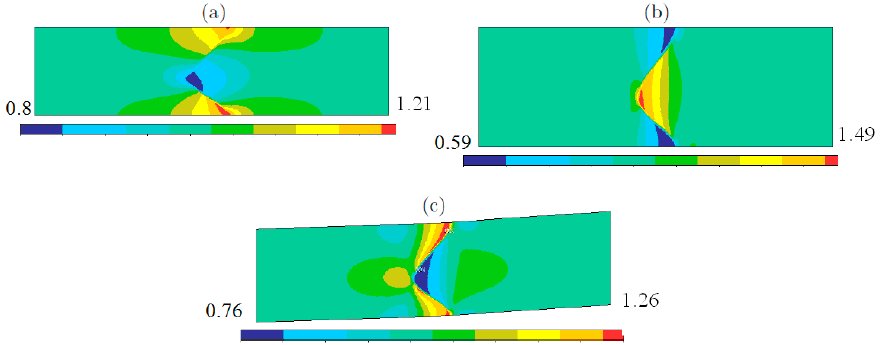
Figure 5. The local von Mises stresses corresponding to the shift for ( a ) symmetric wave, ( b ) asymmetric wave, ( c ) wave with с rest, Figure 3 с .